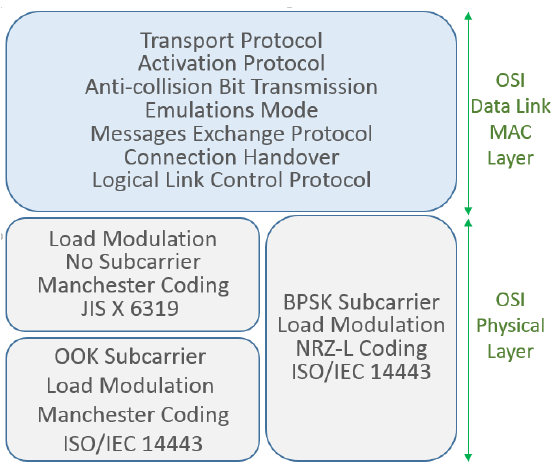
Figure 2. NFC passive to active device communication protocol